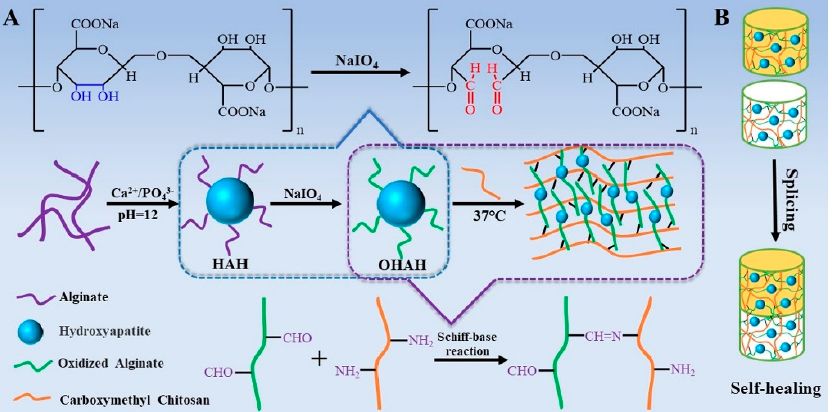
Figure 5. Schematic illustration of the preparation of the hydrogel based on alginate (ALG), hydrox- yapatite (HA), and carboxymethyl chitosan (CM)–CS. ALG was used for the preparation of HAH hybrids, then ALG was oxidized to form oxidized OHAH hybrid. In the next step, the Schiff base reaction between OHAH and (CM)–CS was launched. The self-healing property of the hydrogel was verified using two parts of the prepared hydrogels, one of the parts was mixed with methyl orange solution. Both parts were then spliced and characterized. Scheme describes: ( A ) the preparation of an injectable hydrogel using Schiff base reaction via chemical reactions as well as schematically, ( B ) the self-healing property of the hydrogels. HAH is hydroxyapatite alginate (HA/ALG) hybrids, OHAH is oxidized alginate hydroxyapatite hybrid. Adapted from [108], Elsevier, 2017.